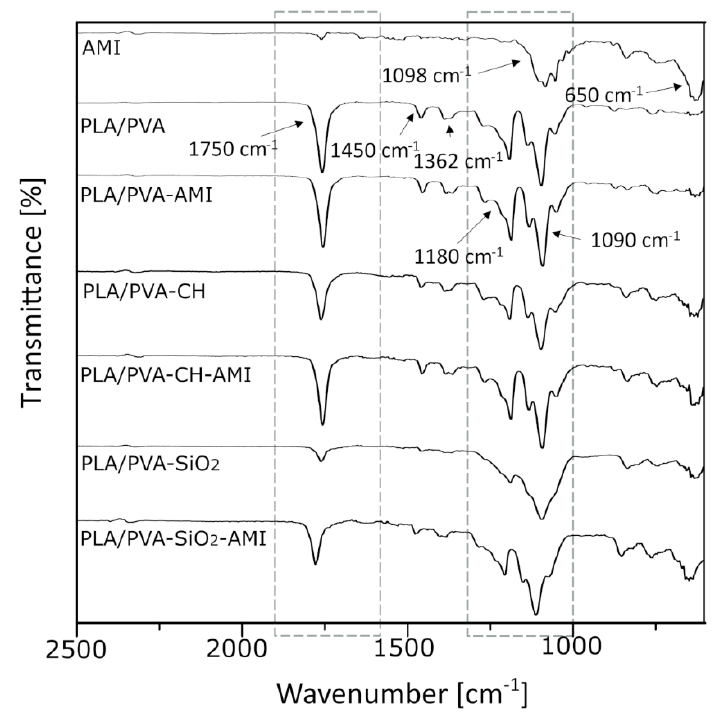
Figure 2. FTIR spectra for the PM before and after modification with AMI.